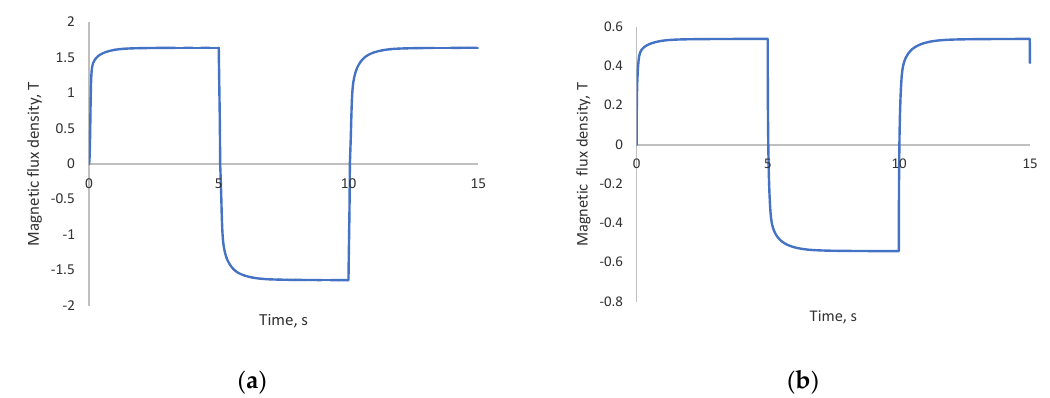
Figure 8. Calculated magnetic flux density in central point of sample: ( a ) EN8, ( b ) AA2014-T6.